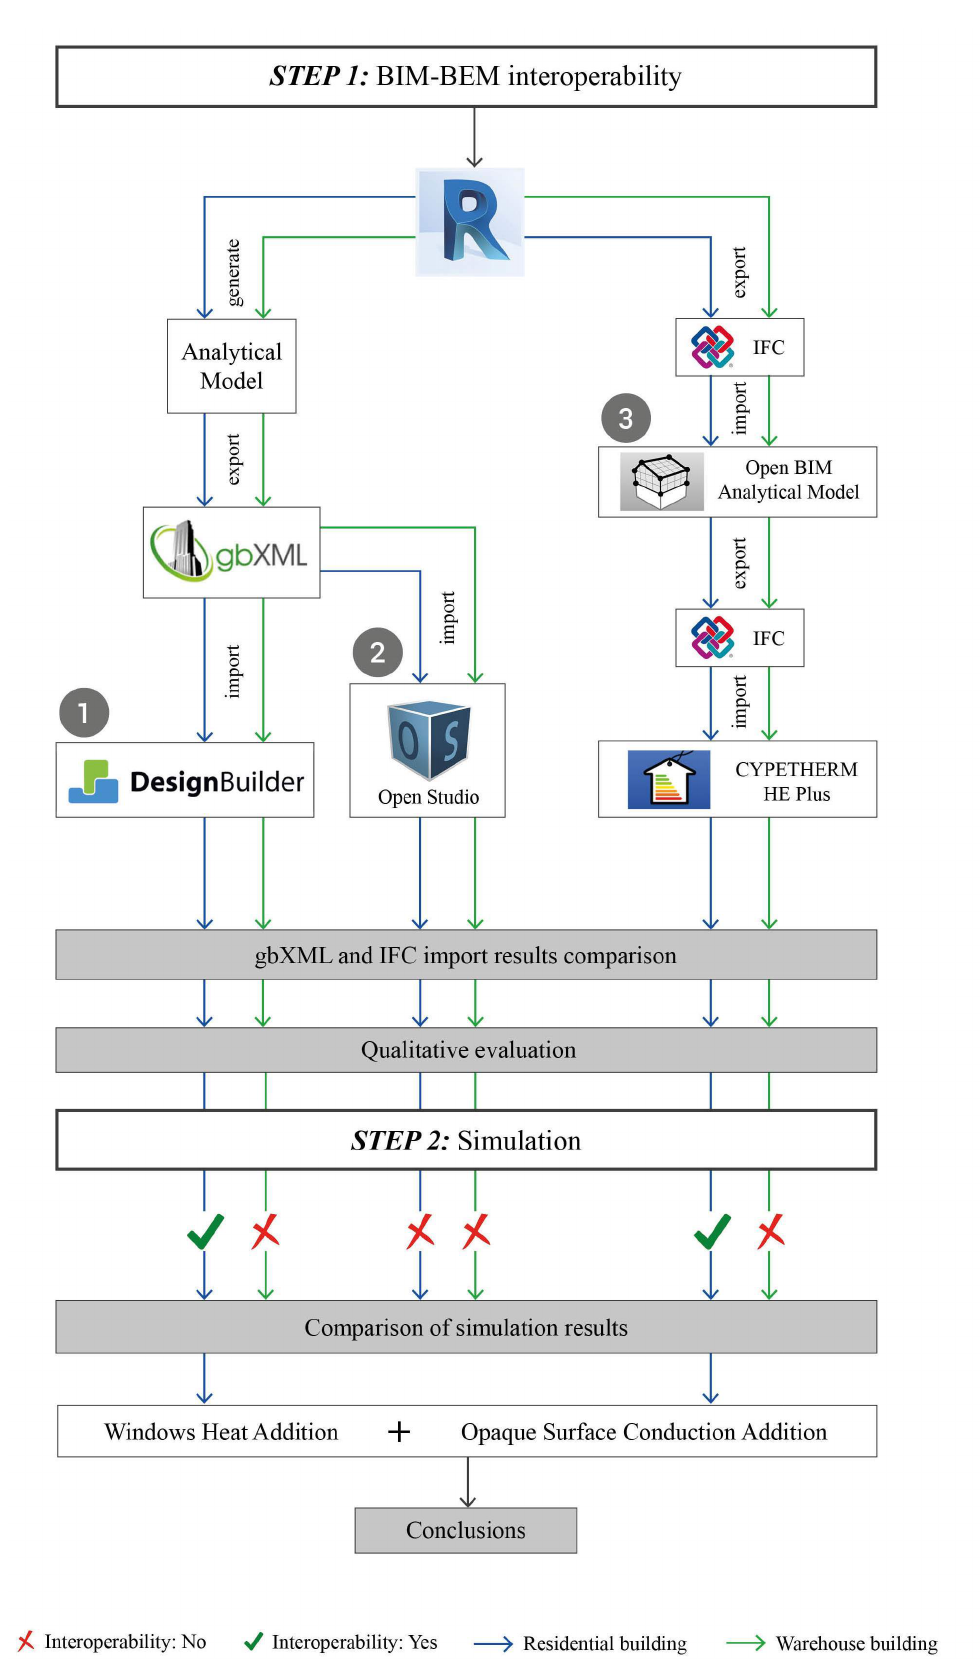
Figure 1. Paper process diagram. Numbers to follow the diagram and import